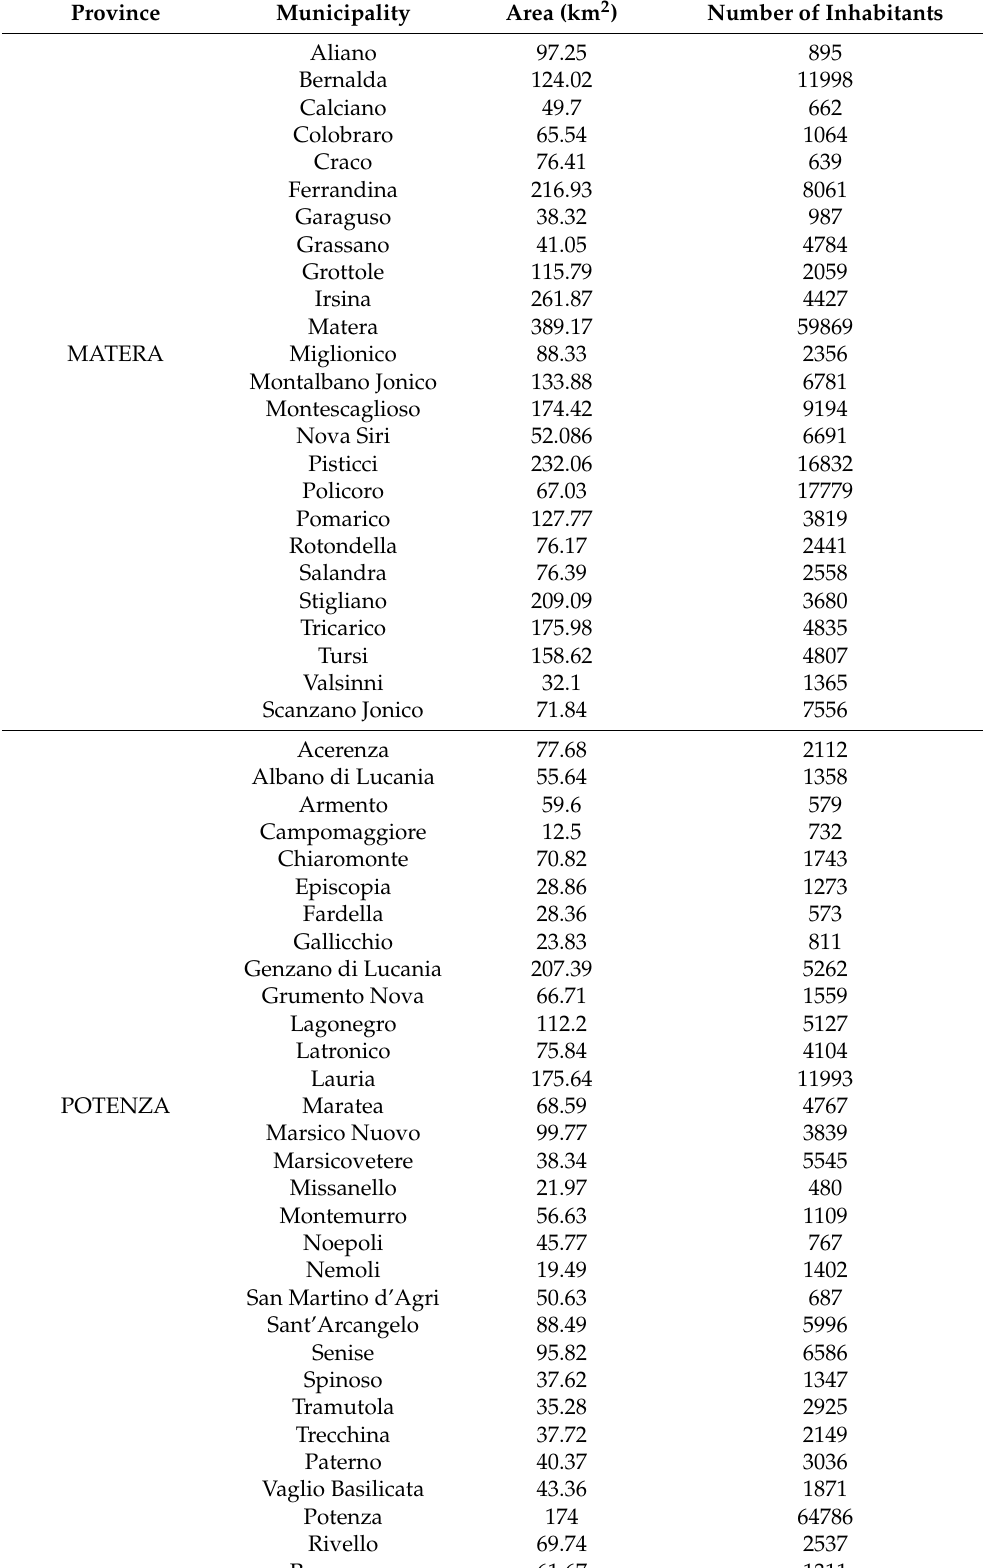
Table 1. Municipalities affected by flood hazard in Basilicata